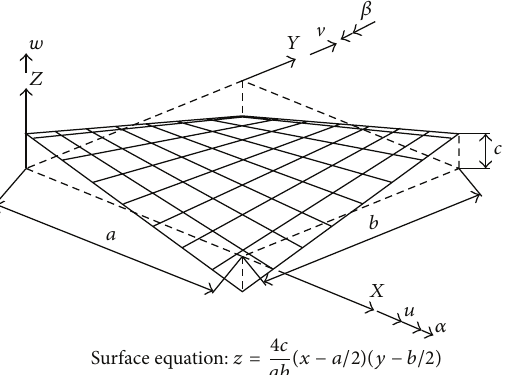
= 13.79 GPa, 𝐺 = 4.64 GPa, ] = 0.30 , 𝜌 = 1.61 × 10 3 kg/m 3 , 𝐸 22 12 12 𝑎 = 𝑏 = 0.14 m, ℎ = 3.81 × 10 −3 m, mass of striker = 0.014175 kg, velocity of striker = 22.6 m/s, contact stiffness (𝑘 𝑐 ) = 1×10 8 N/m 1.5 .